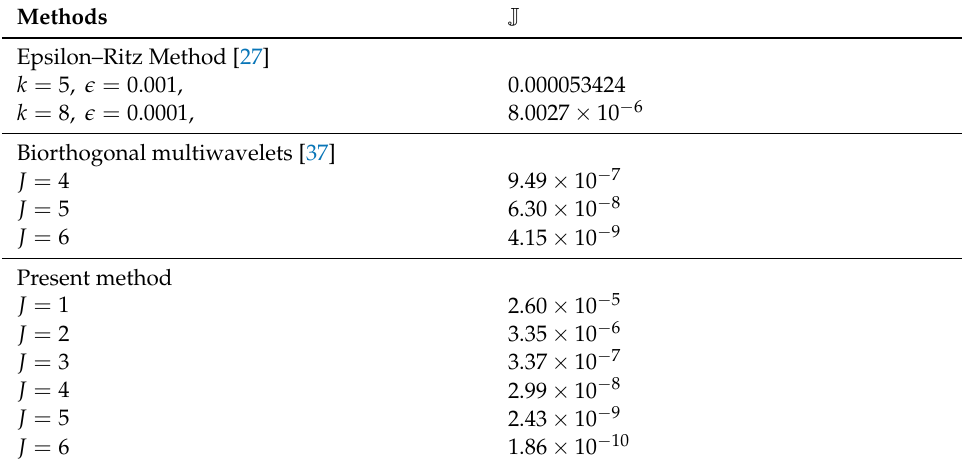
Figure 2. Approximate state and control variables for Example 2. Table 3. The computational results for Example